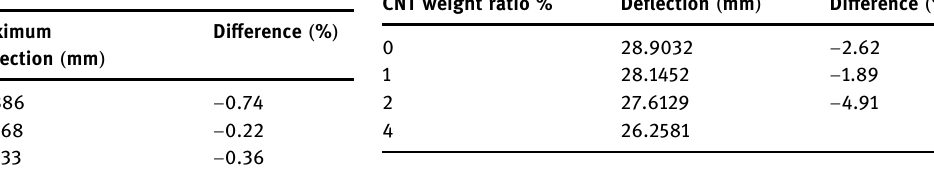
Table 14: De fl ection of the beam at load